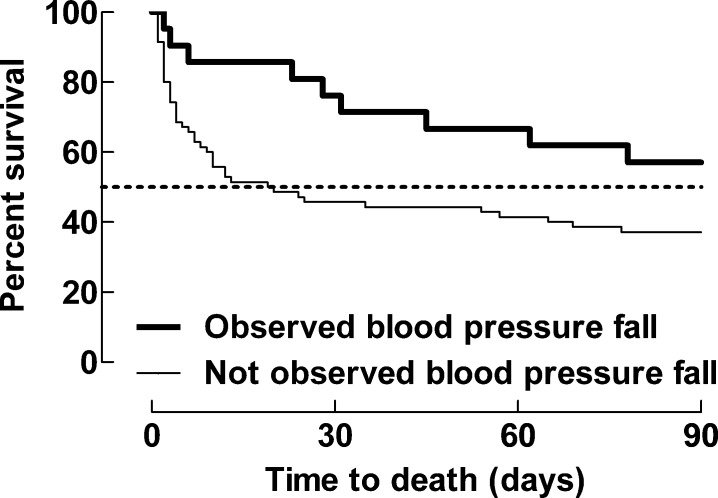
Kaplan-Meier curve comparing patient mortality with point of time was known or unknown for a blood pressure fall below MAP 65 mmHg.p = 0.0291 (Gehan-Breslow-Wilcoxon Test).